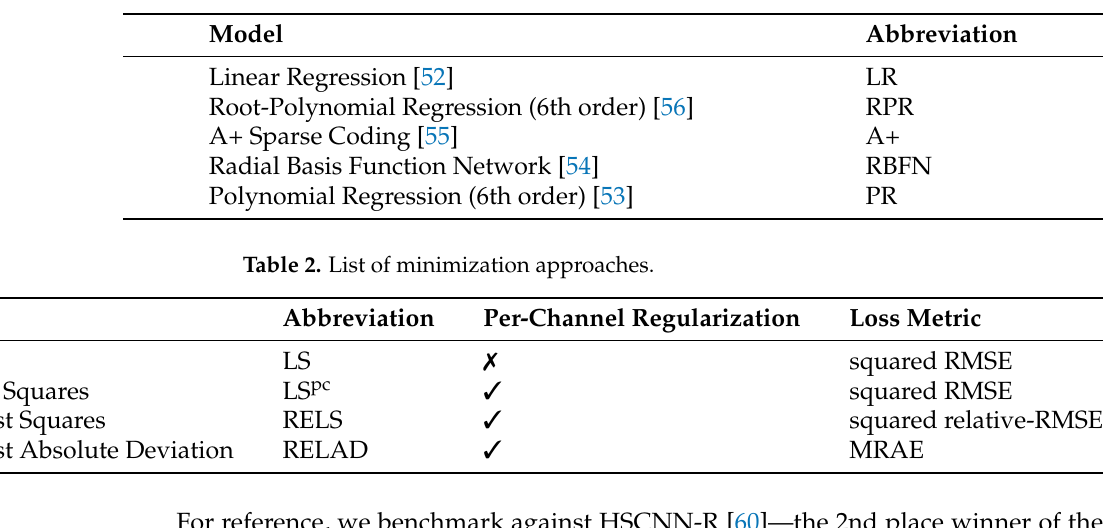
Table 1. List of considered regression models.